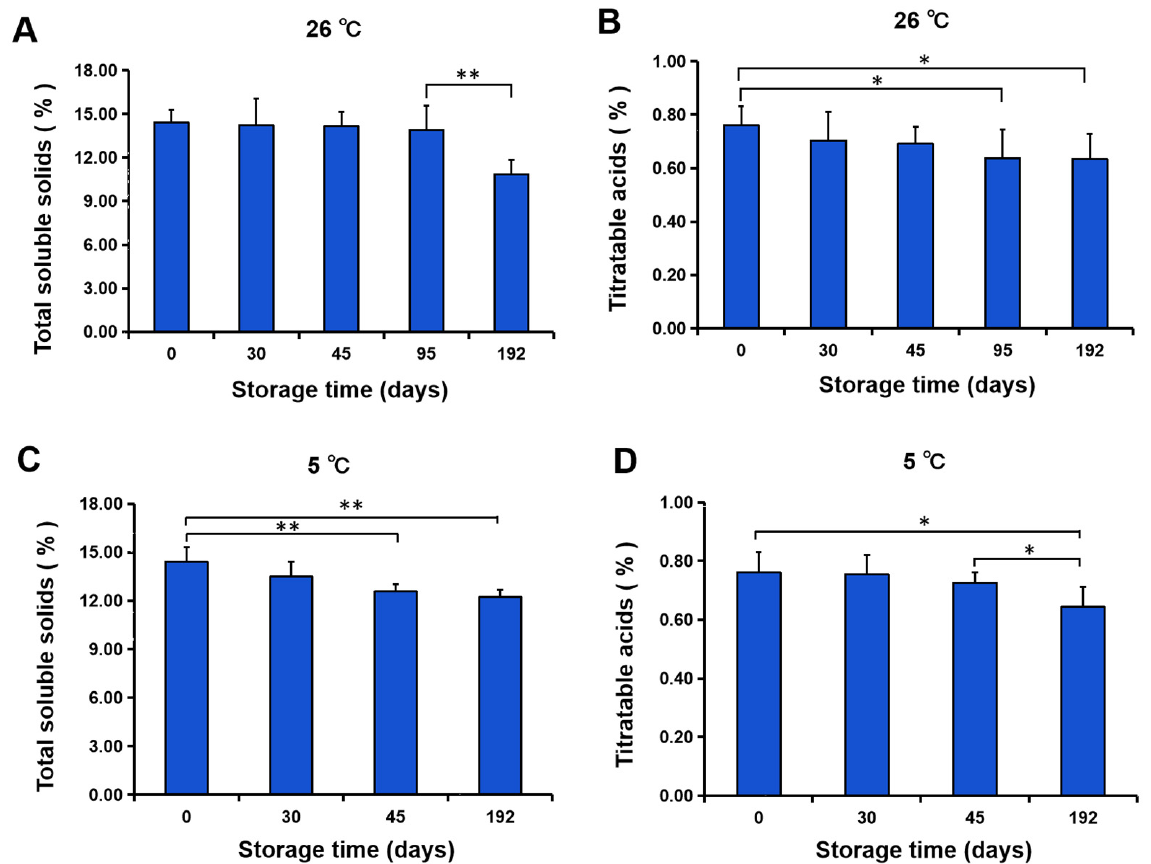
Figure 11. The changes in TSS and TA contents of navel orange fruit during storage at 26 and 5 °C. ( A , B ) Total soluble solids ( A ) and titratable acids ( B ) of fruit stored at 26 °C. ( C , D ) Total soluble solids ( C ) and titratable acids ( D ) of fruit stored at 5 °C. The error bars represent the mean ± SD ( n = 6). **, p < 0.01; *, p < 0.05.